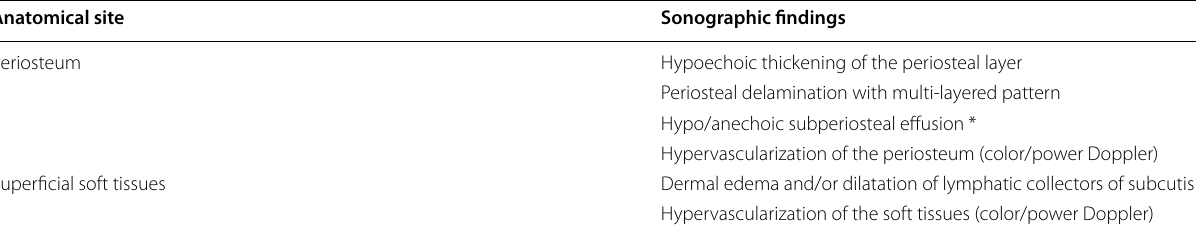
Table 1 Soft tissue abnormalities in stress fractures